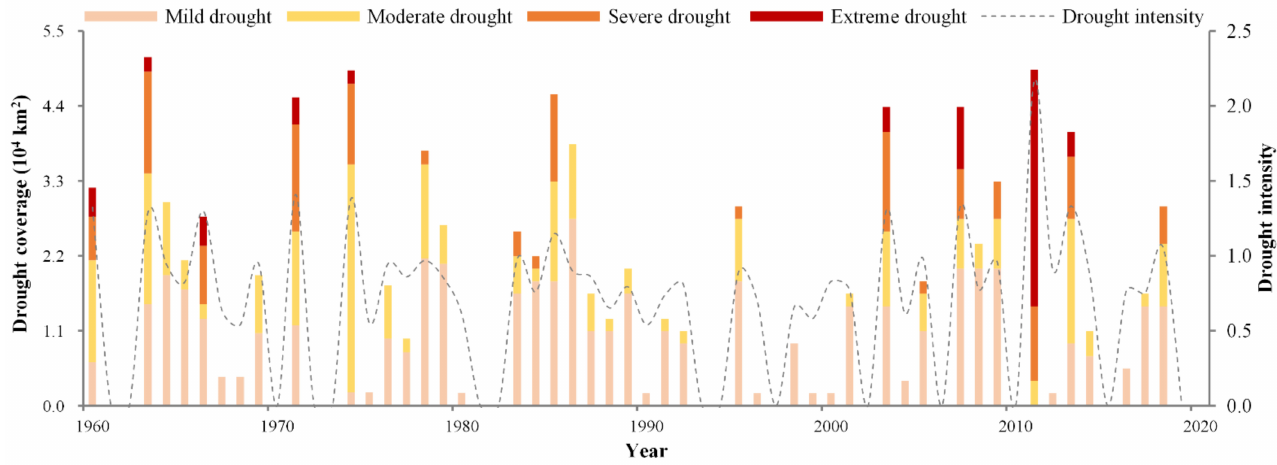
Figure 4. Drought coverage and intensity at an annual scale in HSDC,